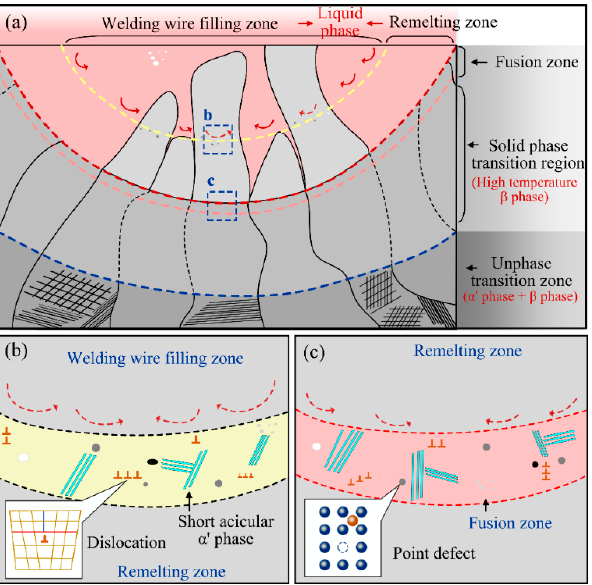
Figure 9. Analysis of the mechanism of the microstructure evolution in the interlayer weld area: ( a ) diagram of the weld zone, ( b ) microstructure evolution near the upper boundary of remelting zone, ( c ) microstructure evolution of the fusion zone.